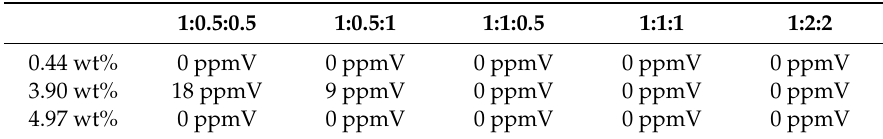
Table 4. Comparison of maximum concentration of formed C 2 H 6 with illumination time among di ff erent molar ratios of CO 2 / H 2 / H 2 O and Pd loading weight with UV light illumination.